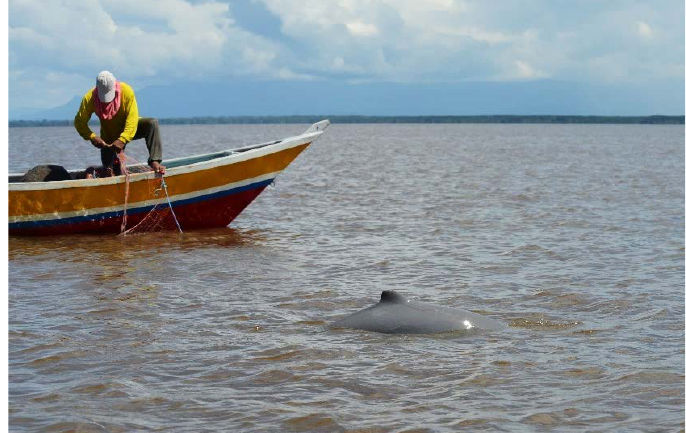
Figure 11. Sighting of Irrawaddy dolphin feeding near a fishing boat.